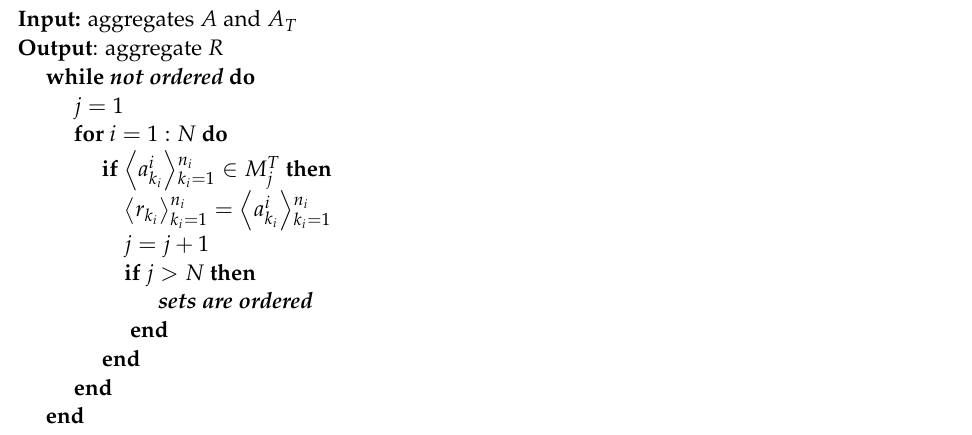
Figure 3. An example of two incompatible aggregates.